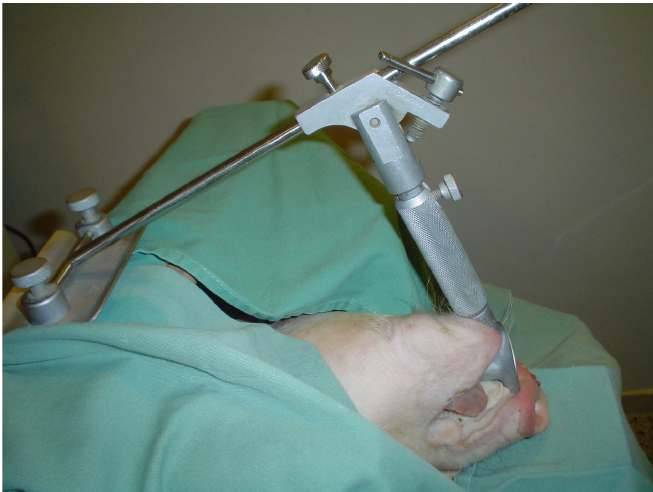
FIGURE 2 – Laringoscopy arrangement and suspension for larynx exposure and microscope introduction